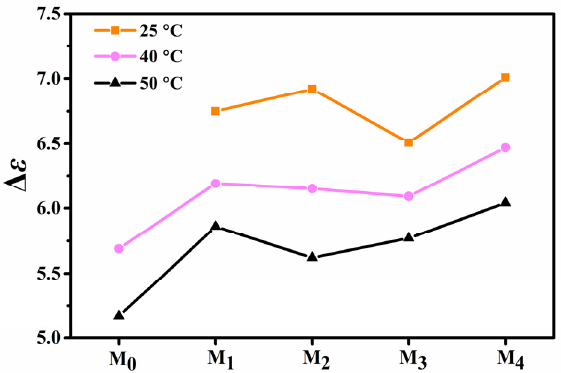
Figure 6. The dielectric anisotropy values of LC mixtures at 25 °C, 40 °C, 50 °C.